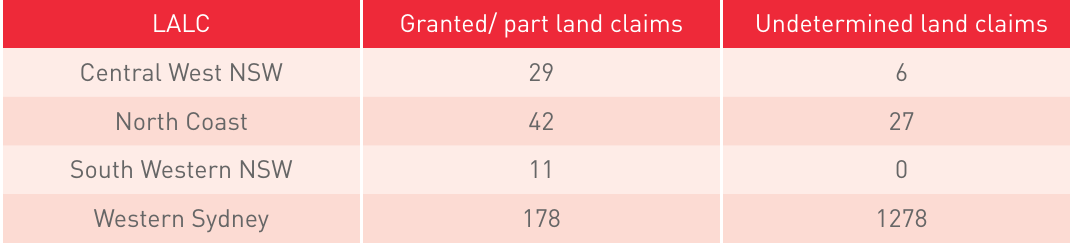
Data arranged by LALC as at October